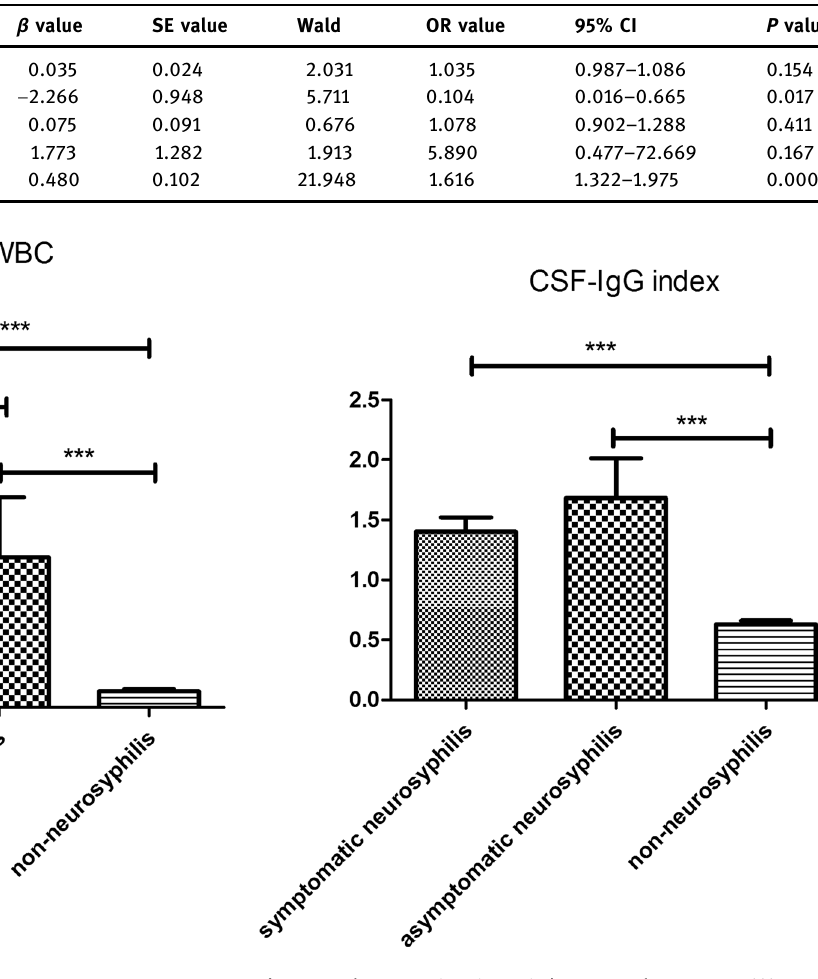
Figure 3: The comparison in WBC count among three groups. * p < 0.05; *** p < 0.01.